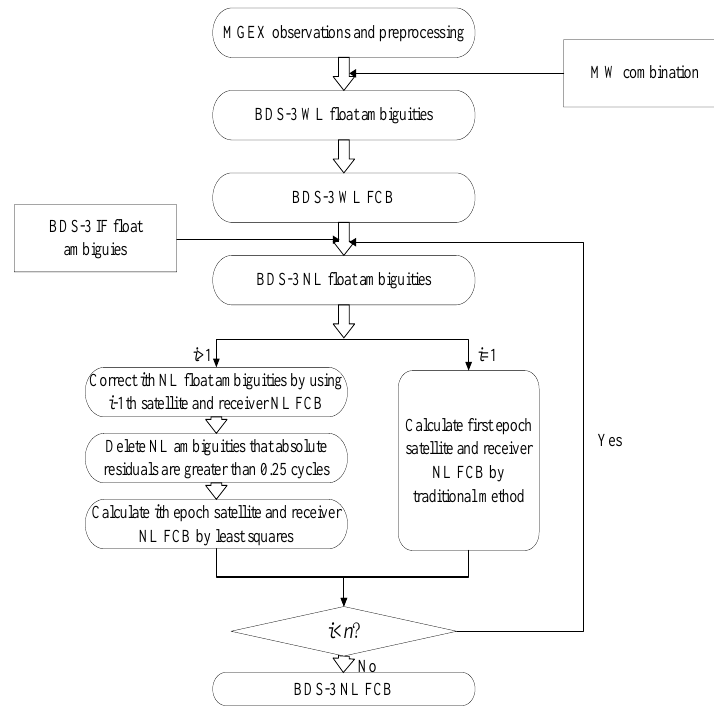
Figure 2. The flowchart of improved BDS-3 FCB method of estimation.